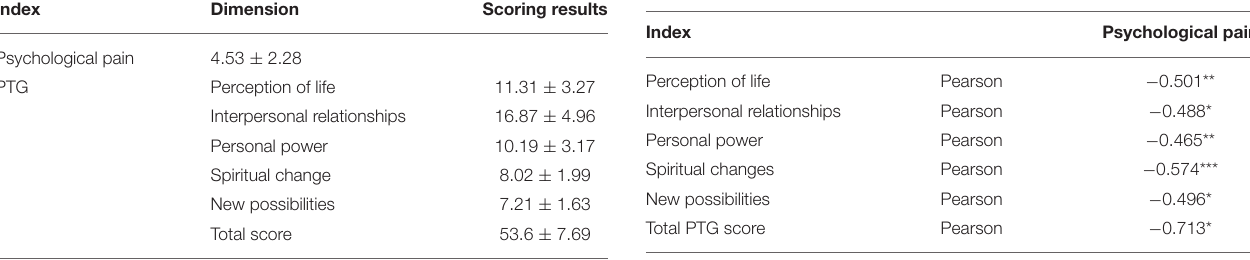
TABLE 2 | COVID-19 patients’ psychological pain and PTG ( ¯ χ ± s sub). TABLE 3 | Pearson correlation analysis between COVID-19 patients’ psychological pain and